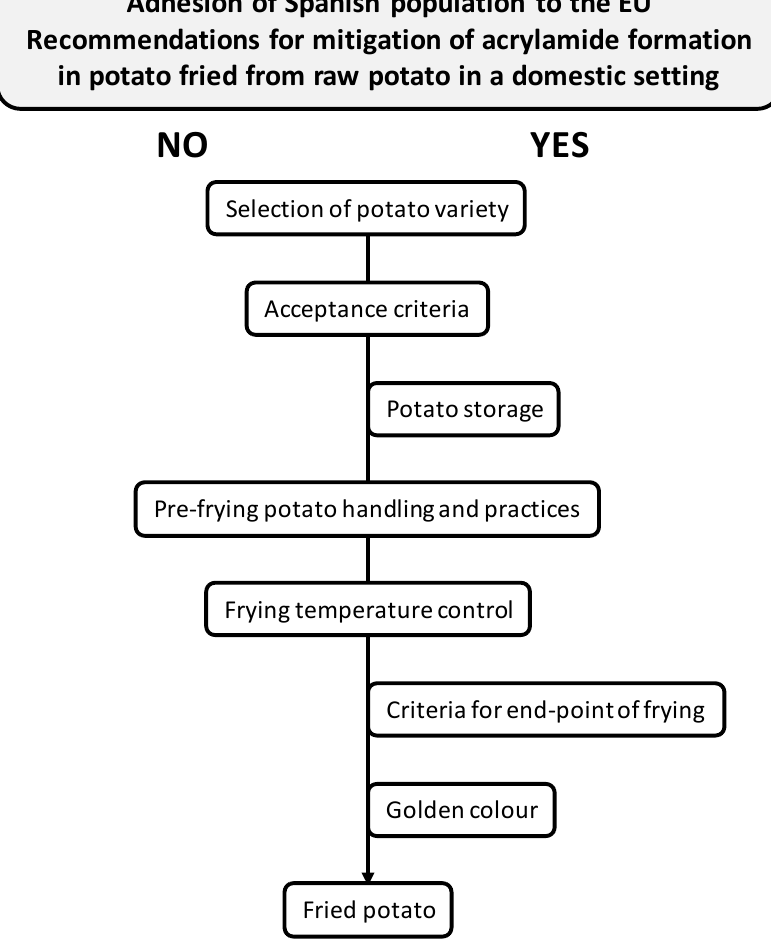
Figure 4. Adherence of the Spanish population to EU recommendations for the mitigation of acrylamide formation in potatoes fried from raw potatoes in a domestic setting [5].